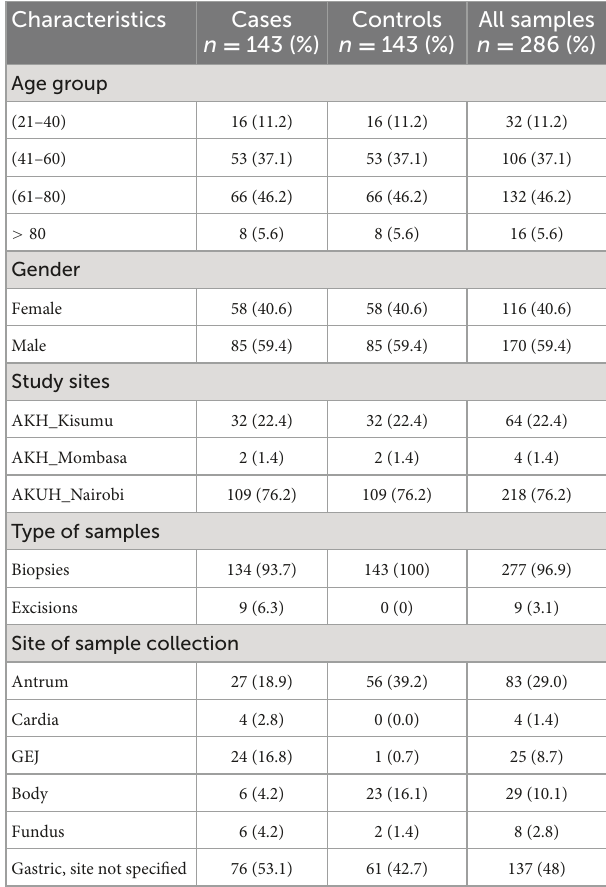
TABLE 1 Baseline characteristics of the samples